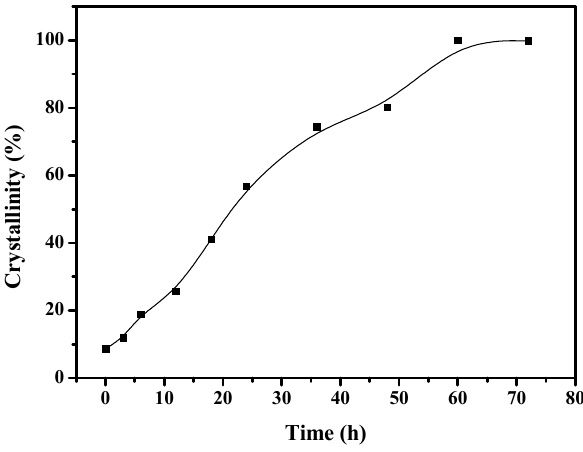
Figure 9. The dependence of S-Beta crystallinity over crystallization time.